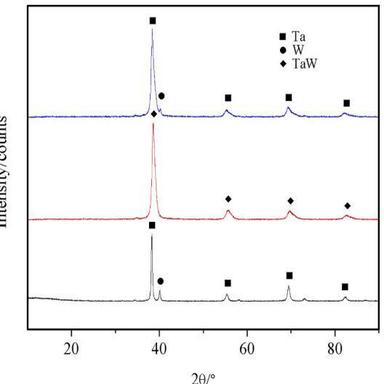
Schematic description of the coatings and substrate. (a)Ta10W raw powder, (b)Ta10W side SPS at 1600o C, (c) Ta10W side SPS at 1300o C by 2 steps.